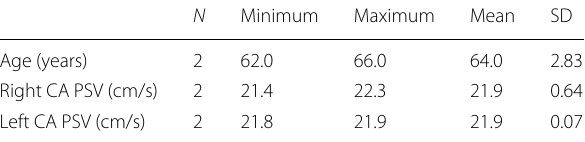
Table 2 Frequency distribution of the patients with arteriogenic ED and their respective Cavernosal artery PSV